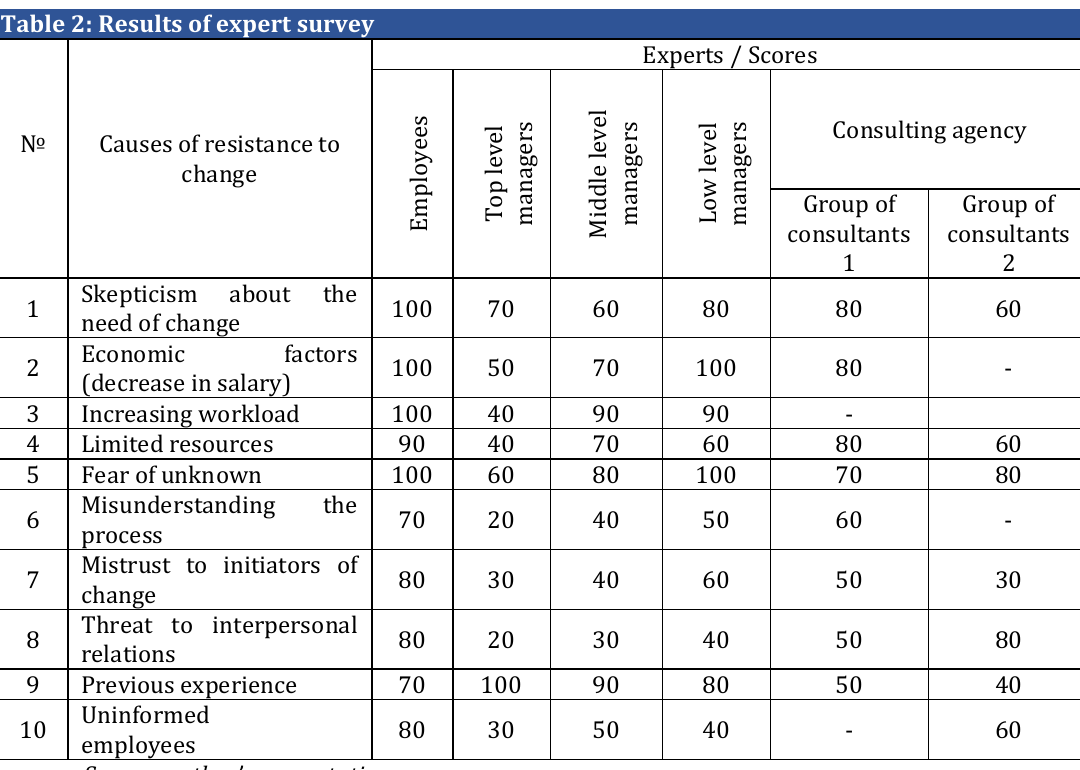
Table 2: Results of expert survey